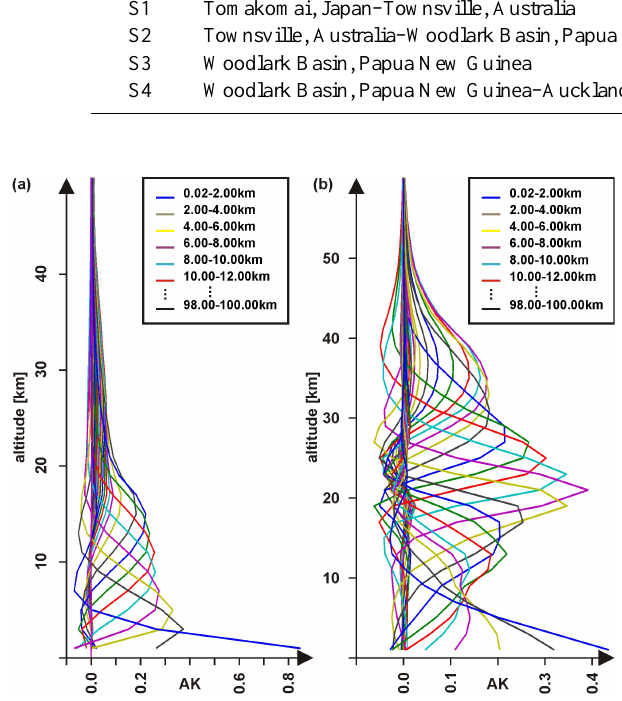
Fig. 2. Representative averaging kernels of the FTIR (a) CO re- trieval and (b) O 3 retrieval. The colored lines indicate the sensitivity and resolution of each individual